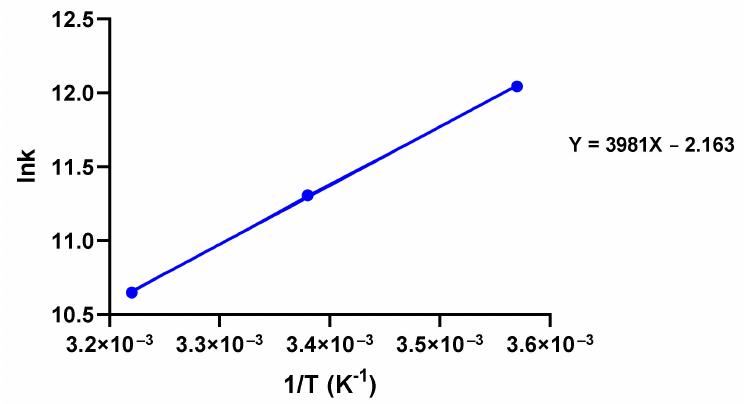
Figure 8. Van’t Hoff plot of fluorescence quenching and analysis of thermodynamic parameters to unravel the type of forces between CBD and tau protein.